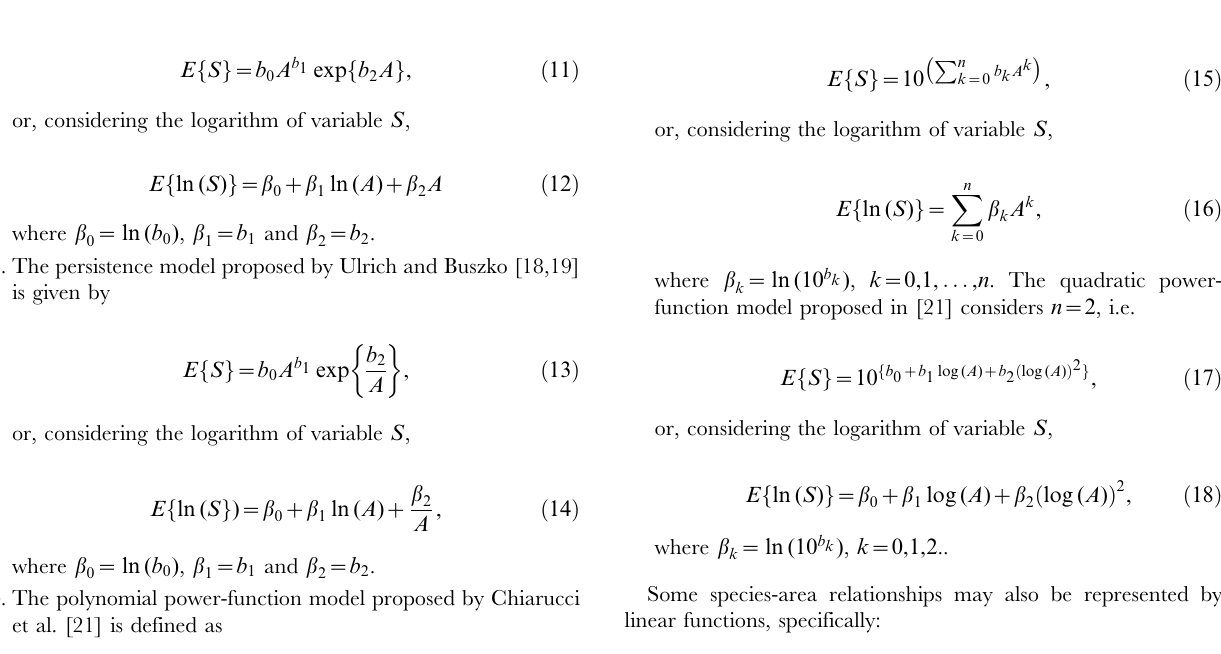
Figure 1. Data and fitted curve obtained by the GSMA model for the simulated species-area relationship.